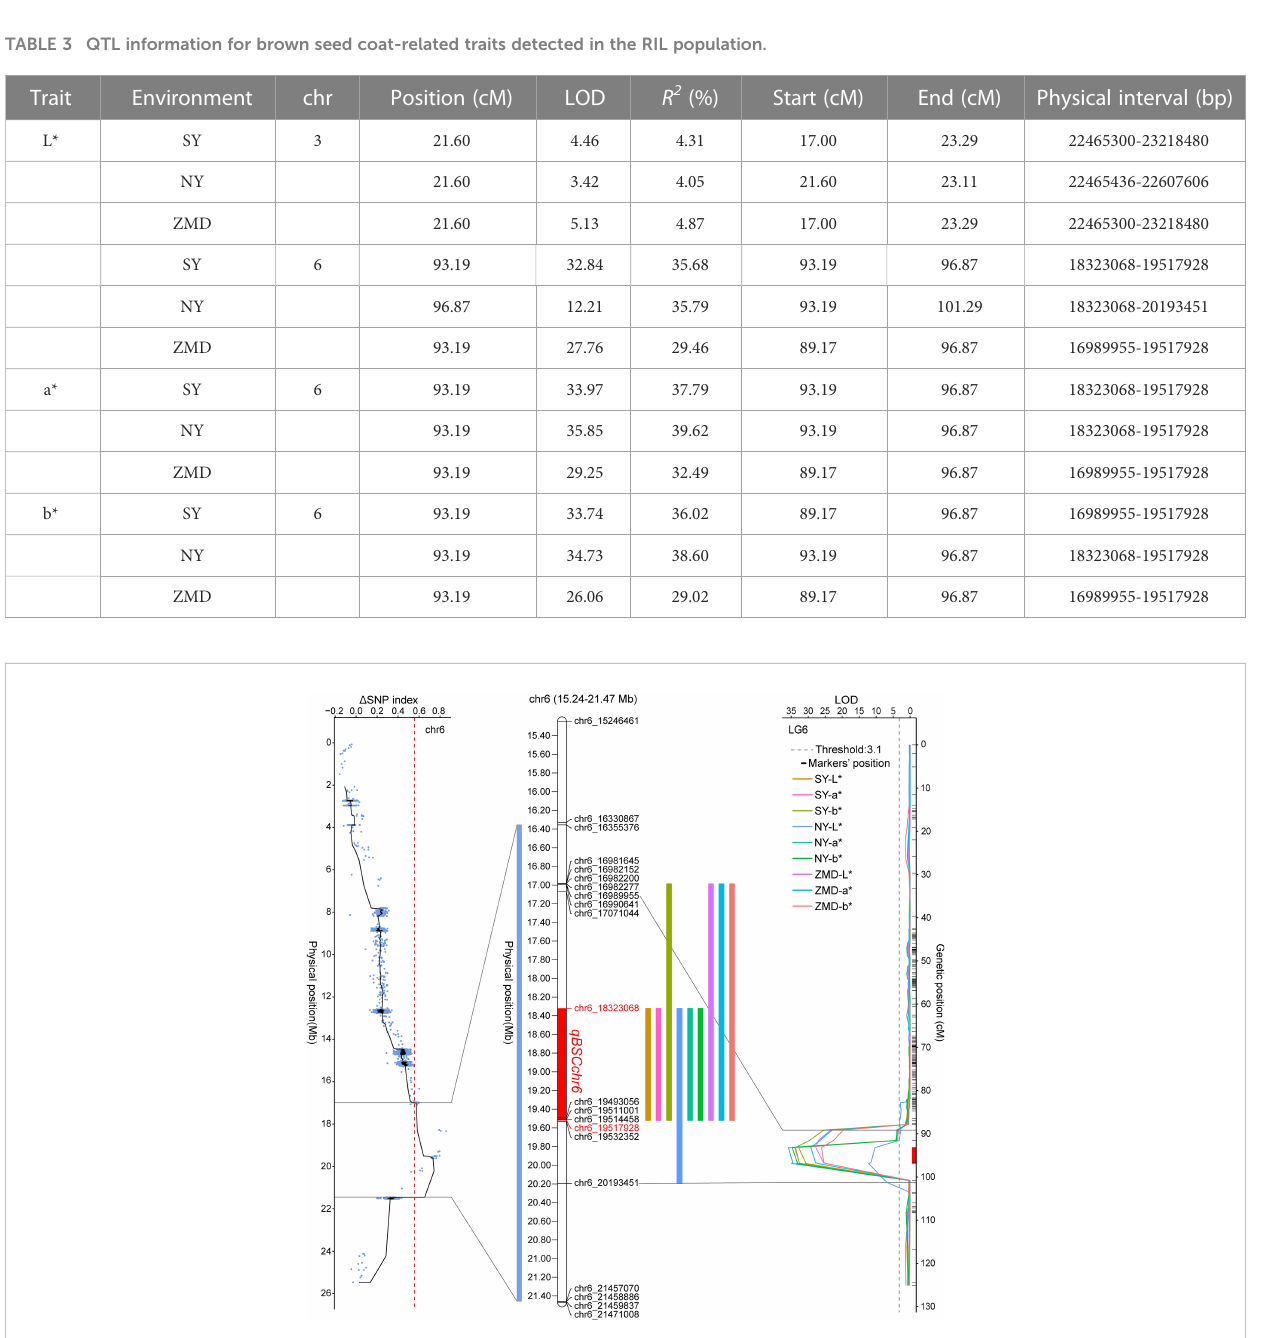
FIGURE 3 Position of qBSCchr6 on the chr6 physical map. Colored boxes represent the physical distance spanned on chr6 for QTL identi fi ed by BSA and QTL